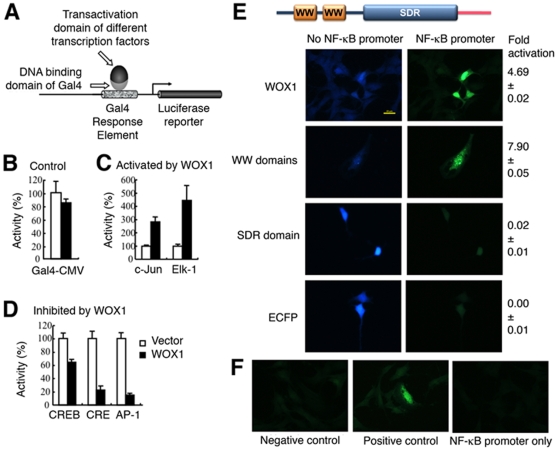
WOX1 modulates promoter activation driven by multiple transcription
factors.(A) A schematic diagram for the Gal4-based promoter
activation assay using luciferase reporter is shown.
(B–D) EGFP-WOX1 was transiently overexpressed
in HEK-293 fibroblasts, in the presence of a specific promoter construct
and a luciferase reporter [31], [32]. In control cells, EGFP and Gal4-CMV
vectors were used, which showed no promoter activation. Transiently
overexpressed WOX1 significantly enhanced the promoter activity
regulated by c-Jun and Elk-1 (p<0.0005,
n = 3, Student's
t test), but blocked the activation of promoter
elements responsive to transcription factors CREB, CRE, and AP-1
(p<0.005,
n = 3). (E) Neuroblastoma
SK-N-SH cells were transfected with an indicated construct for
ECFP-tagged WOX1 or ECFP alone, in the presence or absence of an
NF-κB promoter (using GFP as reporter). The wild type WOX1
significantly increased promoter activation by 4.69 fold
(mean±standard deviation,
n = 10), compared to ECFP alone
(p<0.00001). By domain mapping, the
N-terminal first and second WW domains of WOX1
dramatically enhanced the activation of promoter by 7.90 fold. However,
SDR domain had no effect. A schematic structure of WOX1 is shown.
(F) In control experiments, no promoter activation was
observed using a negative, a positive, and an NF-κB promoter
only in transfecting SK-N-SH cells.